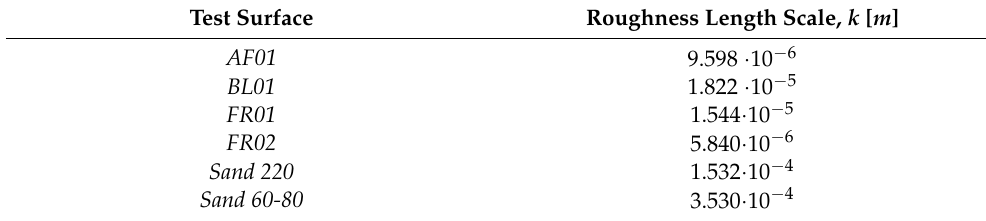
Table 6. Curve fitting coefficients of the roughness functions for the test surfaces.